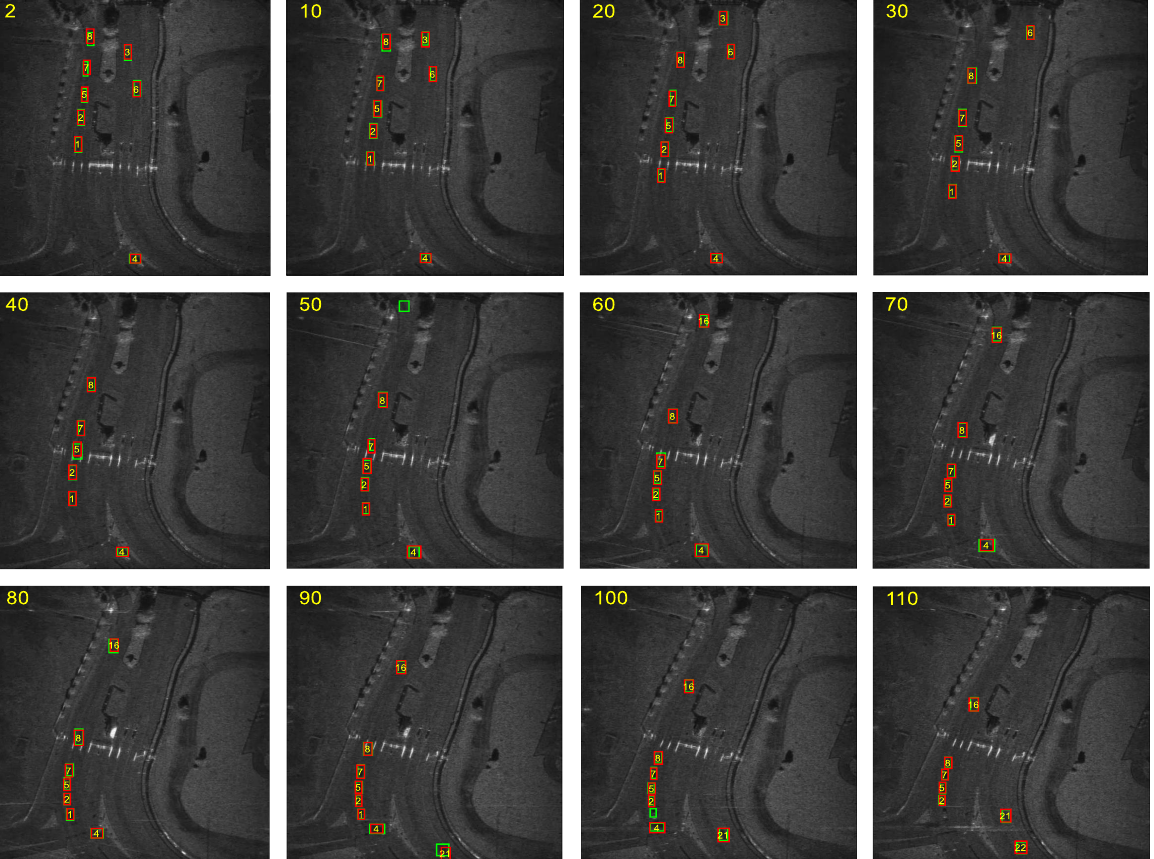
Figure 22. Detection results obtained by using multi-scale Faster-RCNN on eight